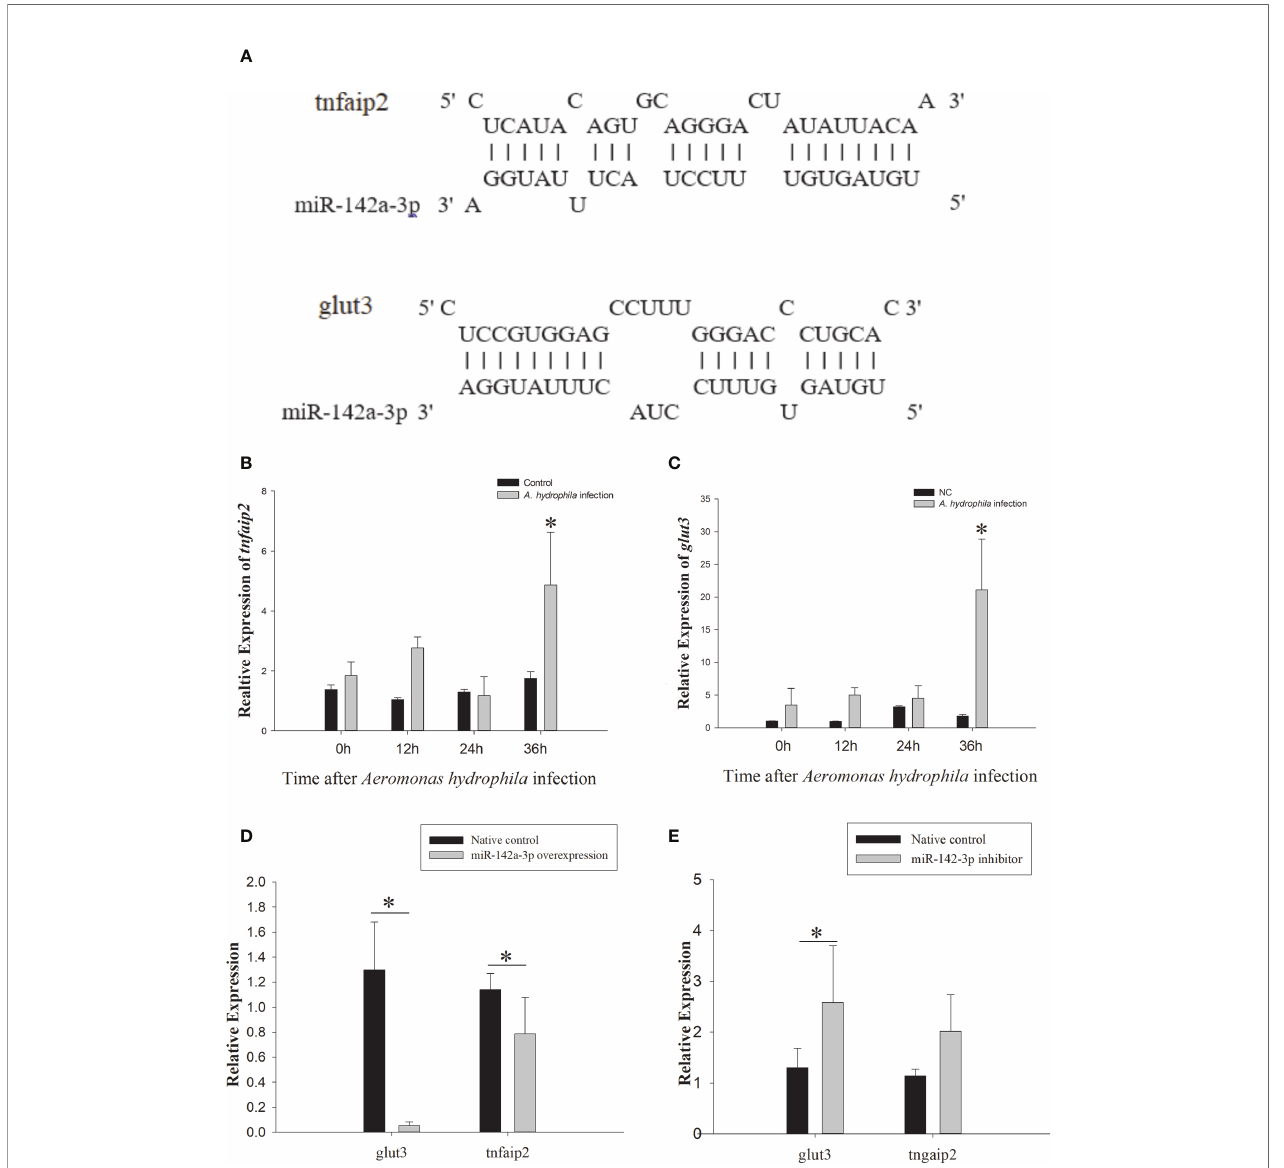
FIGURE 2 | Prediction and validation of target genes of miR-142a-3p. (A) Binding site (as shown with a solid line) of miR-142a-3p to 3 ′ UTR of tnfaip2 and glut3. (B, C) Expression pro fi les of tnfaip2 and glut3 in grass carp kidney (CIK) cells at 0, 12, 24, and 36 h following A. hydrophila infection. (D, E) Relative expression of tnfaip2 and glut3 in CIK cells after miR-142a-3p overexpression or inhibition. All values represent the mean ± SD of three independent experiments. Asterisks indicate signi fi cant differences (* p <